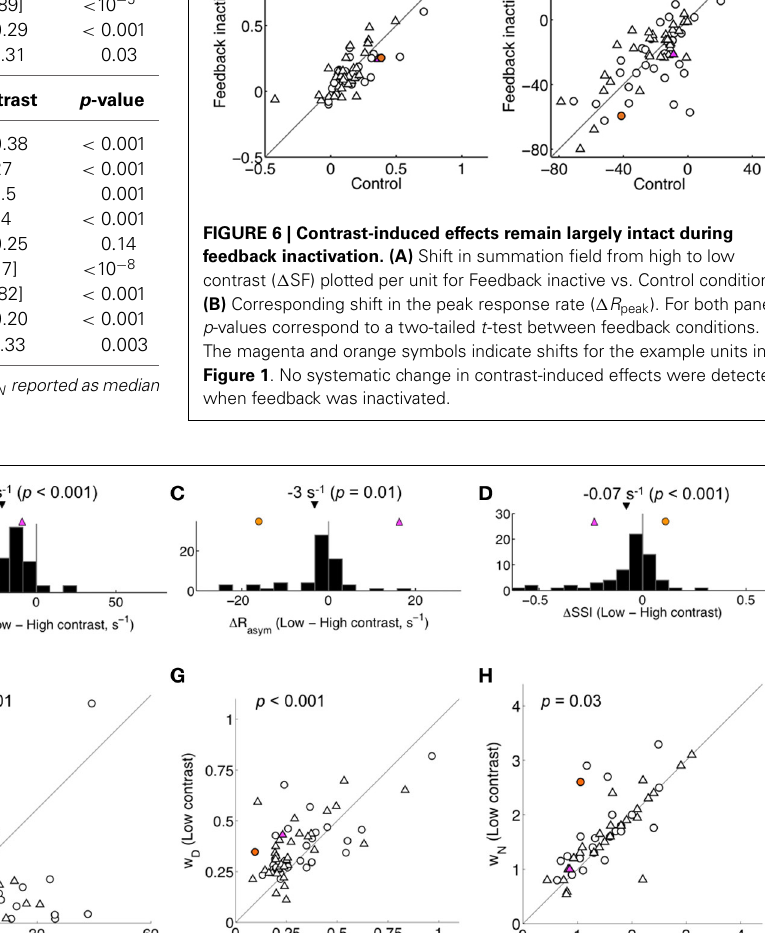
and circles indicate single- and multi-units, respectively. Differences were not detected in any feature (A–D) or parameter (E–H) when comparing across single- and multi-unit subpopulations (each p > 0 . 05). In all panels, the magenta and orange symbols indicate features for example units in Figure 1 . Reducing contrast increased the summation field, decreased the peak response rate, and yielded a small decrement in the asymptotic rate and suppression index. Both gain parameters increased and w D decreased with high